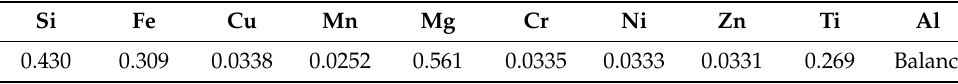
Table 1. Chemical composition of recycled AA 6063 (wt %).